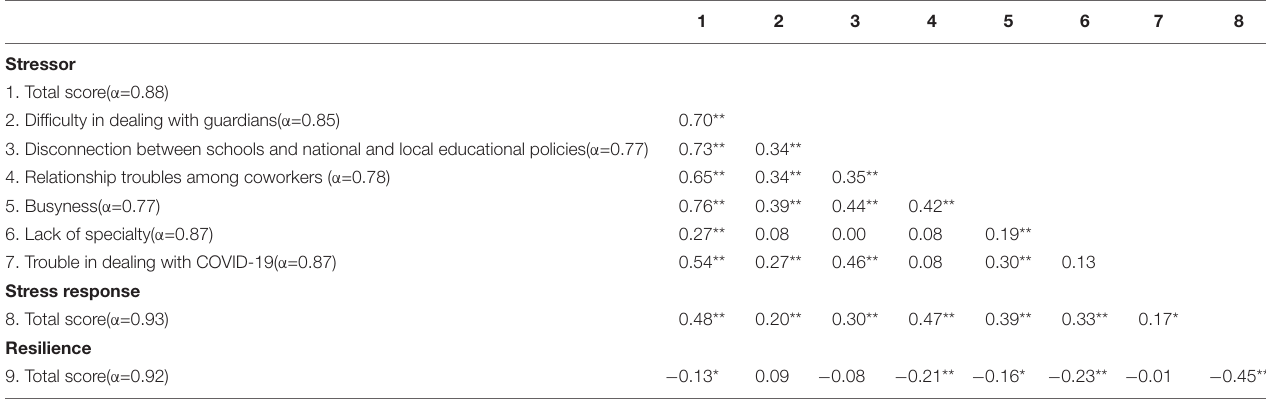
TABLE 2 | Correlation coefficient between each